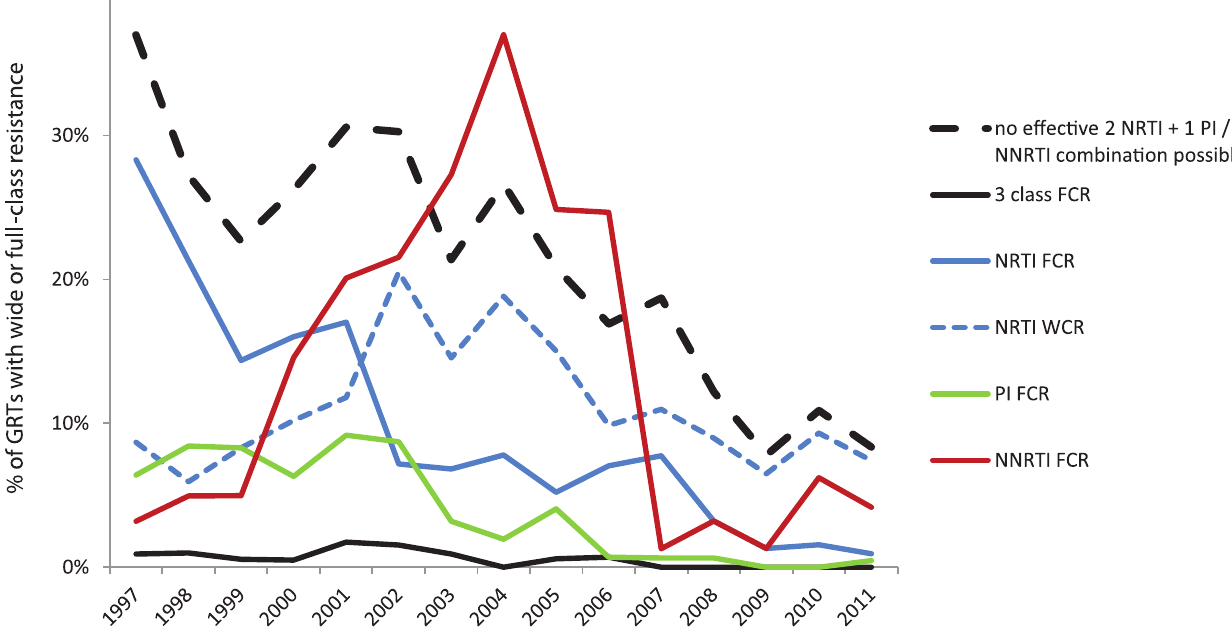
Figure 7. Full-class resistance to one or several classes 1997–2011. Percentage of GRTs containing virus that is fully resistant to one or more drug classes. Full-class resistance (FCR) was defined as intermediate or high-level resistance to all drugs in the class that were available in Sweden that year. In addition, for NRTI, wide-class resistance (WCR) prohibiting the use of an effective 2 NRTI backbone is shown (blue dashed line). The black dashed line shows total resistance prohibiting efficient use of any standard regimen (2 compatible NRTIs + 1 PI or 1